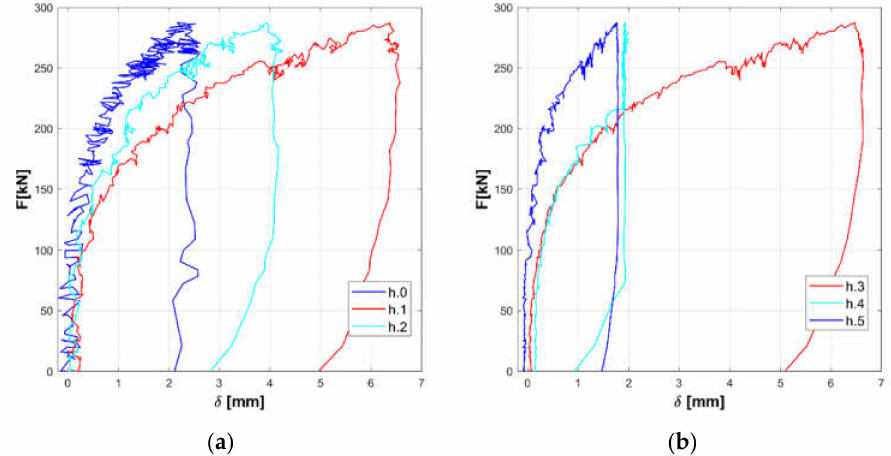
Figure 12. Experimental horizontal displacements of panel C: upper part ( a ) and lower part ( b ).